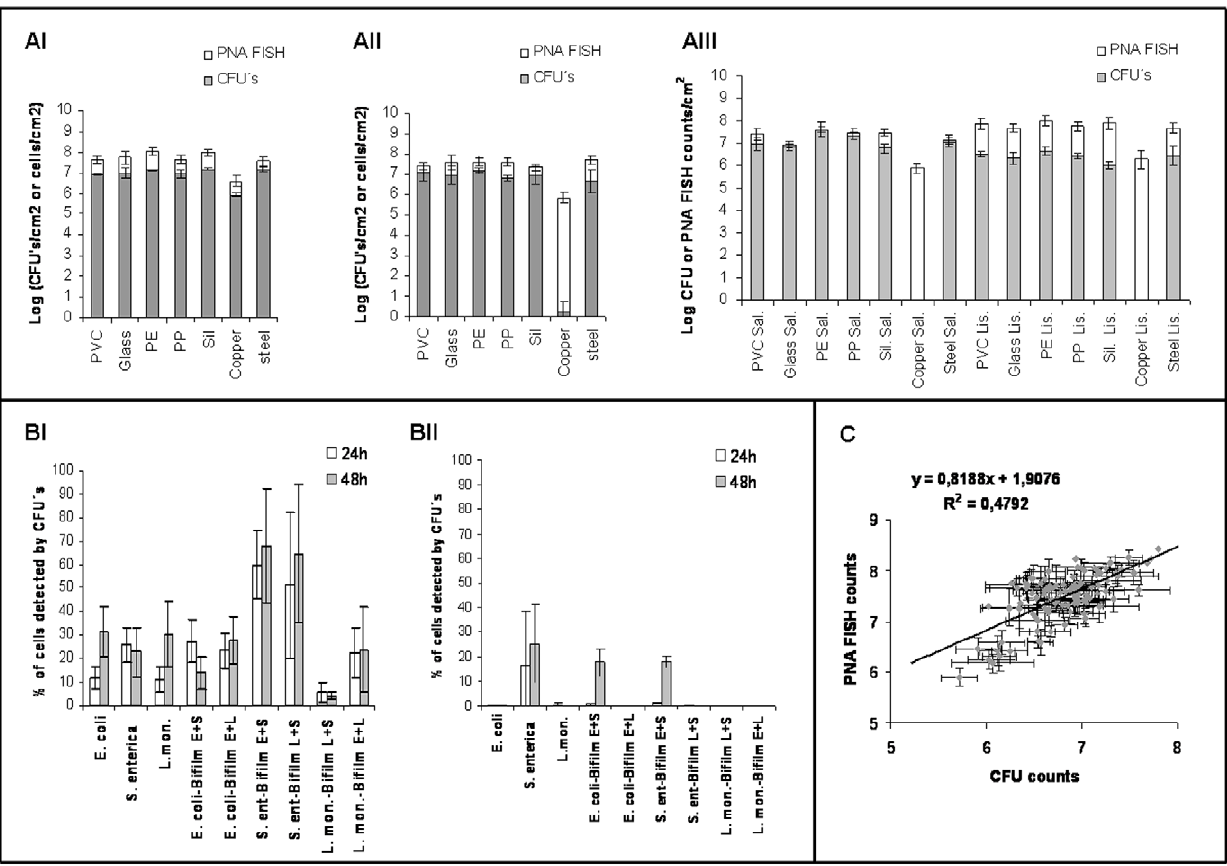
Figure 6. Comparison between PNA FISH/DAPI and cultivability measurements. Viable and cultivable bacteria adhered to the different material for S. enterica (AI) and L. monocytogenes (AII) pure culture biofilm and Salmonella/Listeria dual-especie biofilm (AII). Percentages of cells detected by cultivability for each specie, on single and dual-specie biofilm, adhered to copper (BII) and the remaining six material (BI- average values determined for the six materials together). Correlation between the PNA FISH counts and the CFU counts for 24 and 48 h biofilms (C) (all the 6 biofilm experiments included).